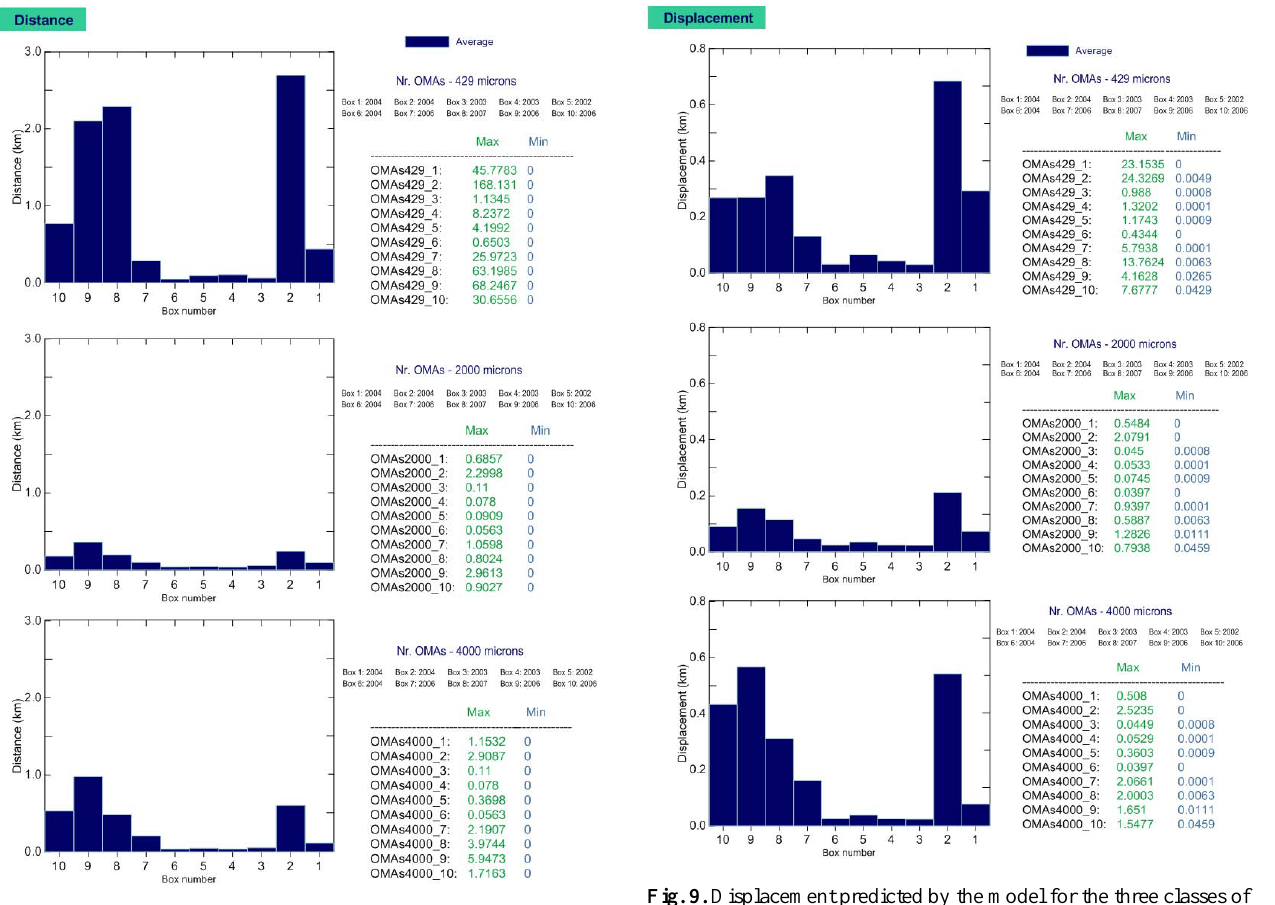
Fig. 8. Distance predicted by the model for the three classes of OMAs.